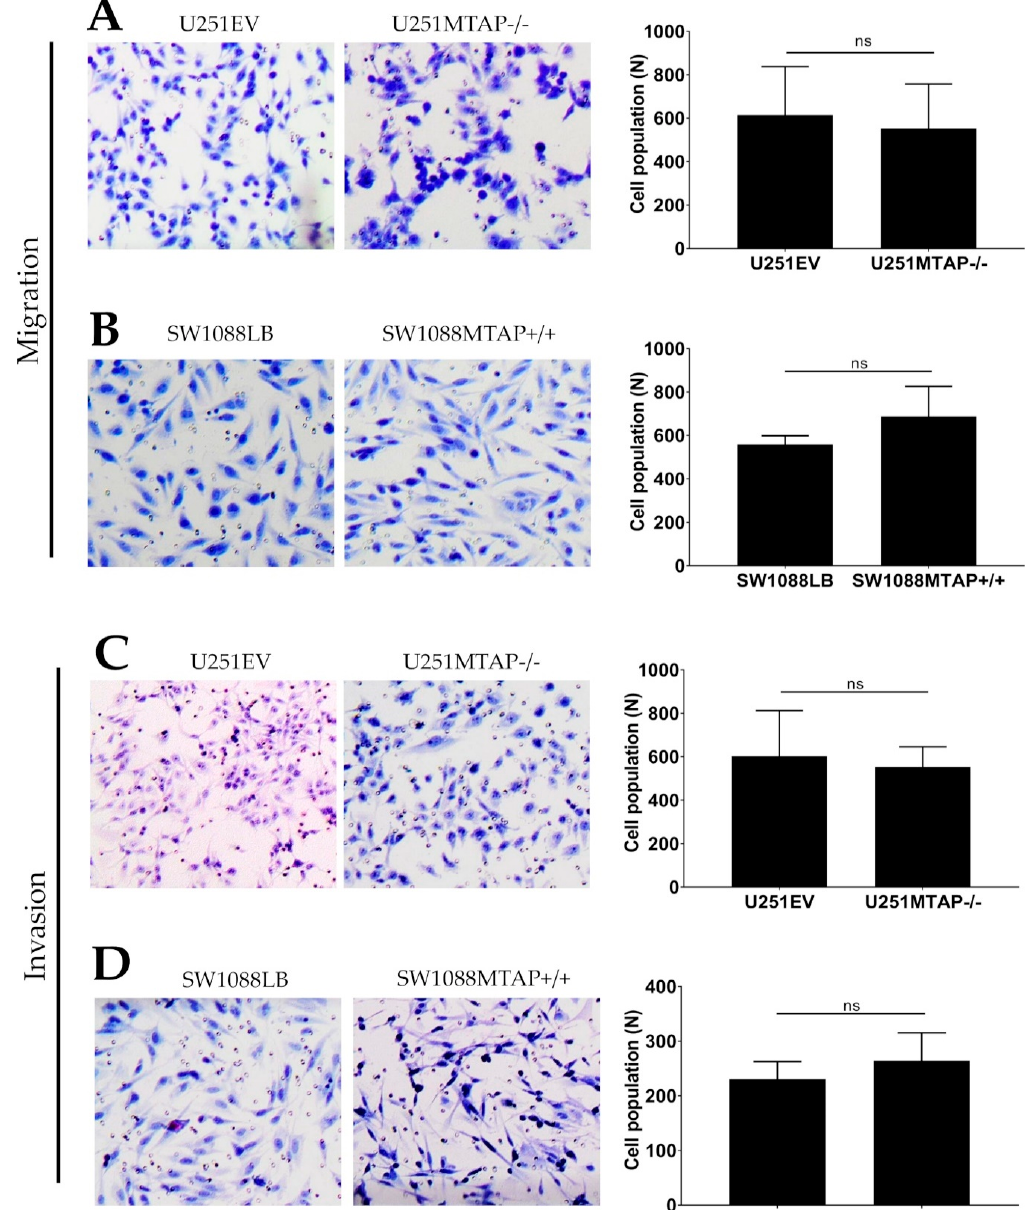
Figure 7. MTAP gene does not modulate migration and invasion abilities . Migration potential in both clone cell lines U251MTAP − / − ( A ) and SW1088MTAP+/+ ( B ) compared to controls (U251EV